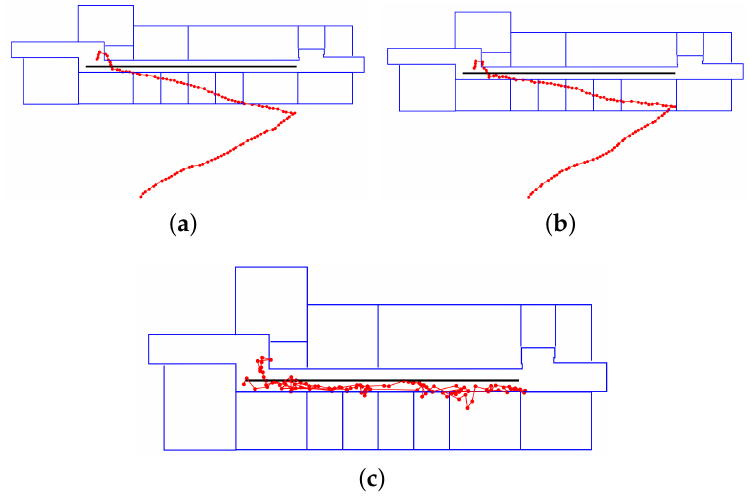
Figure 12. Trajectory of Route 1 when the heading was randomly swayed: ( a ) PDR locations; ( b ) PDR locations after orientation filtering; and ( c ) the path derived from the fusion workflow.